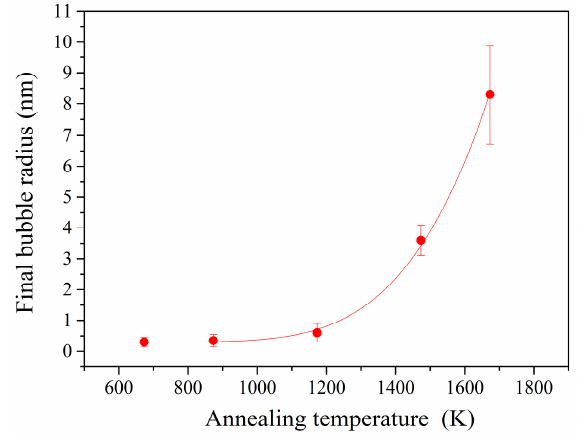
Figure 4. The relationship between final bubble radius and annealing temperature.